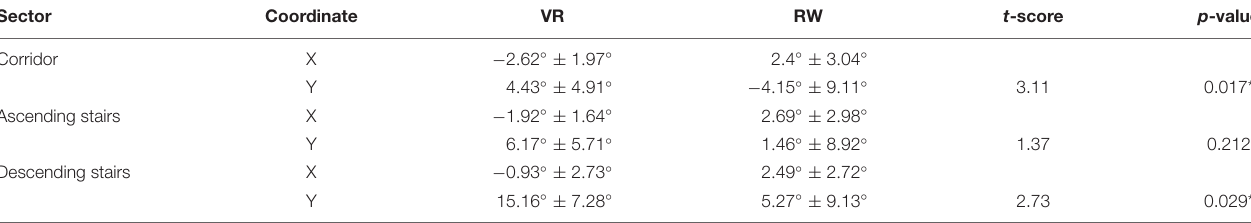
TABLE 1 | Comparison of average gaze between sectors.